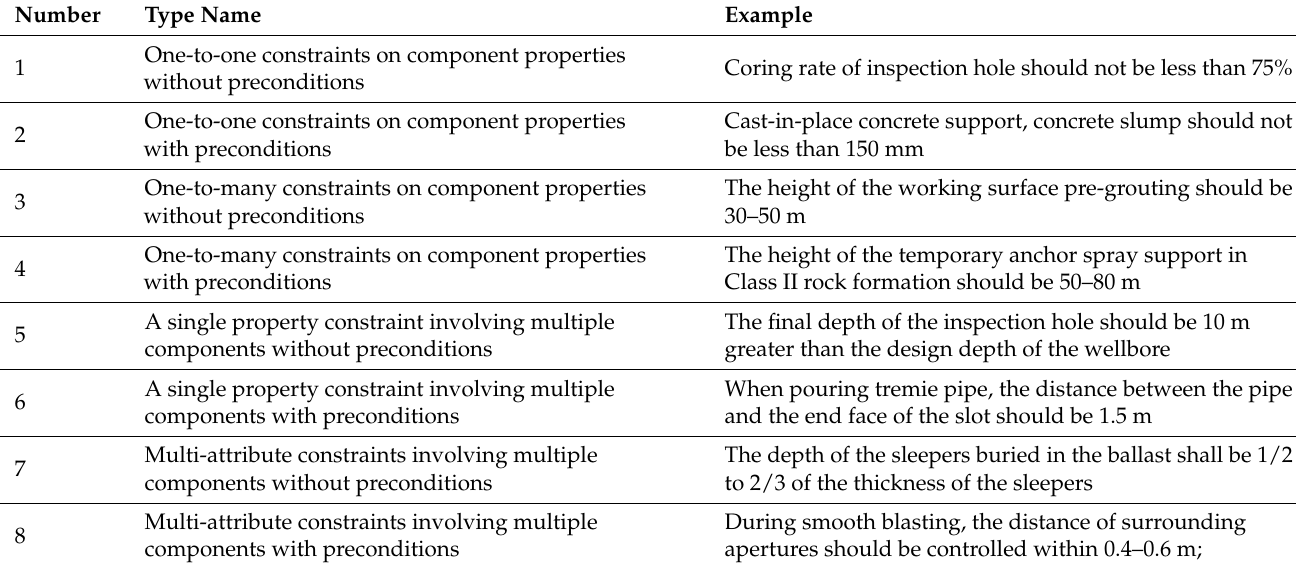
Table 2. Judgment rule